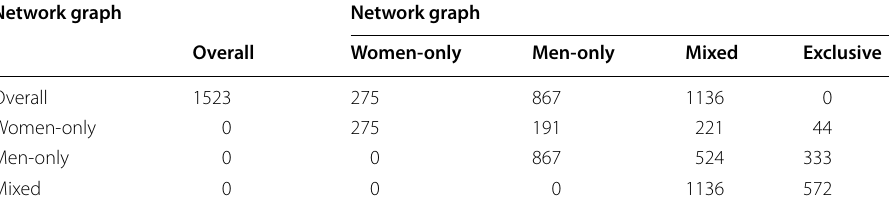
Table 4 Connectedness of festivals per gendered community Network graph Network